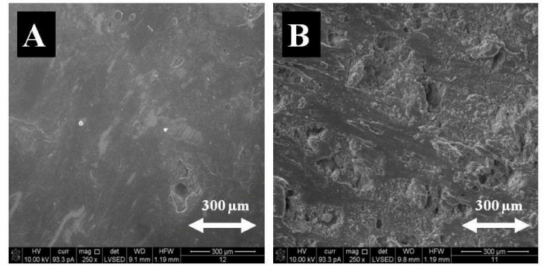
Figure 2. Microstructure of PLA and Fe 3 O 4 composite polymerized without CMF ( A ) and under the exposure to CMF with magnetic induction B = 0.5 T ( B ), image of secondary electrons SE, magnification 250 × .